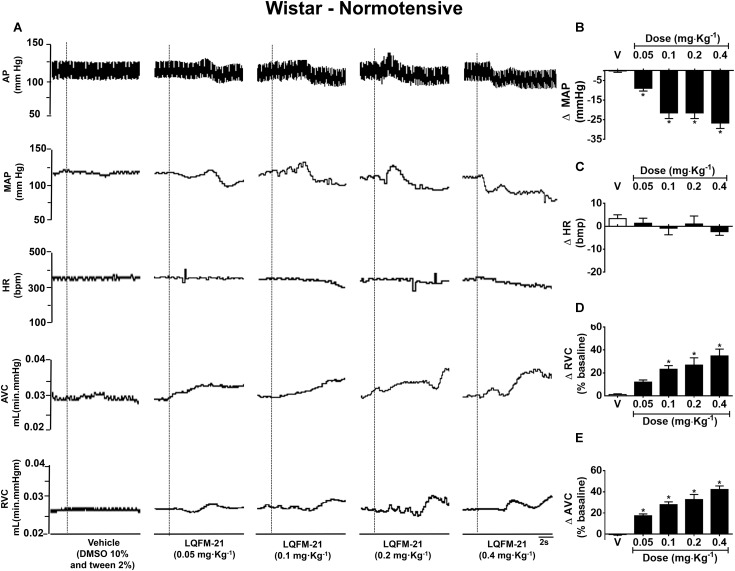
(A) Typical tracing of changes in cardiovascular parameters induced by intravenous injection of vehicle or LQFM-21 in anaesthetized NTR. Dashed line indicates the vehicle or LQFM-21 infusion. (B) Mean arterial pressure (MAP), (C) Heart rate (HR), (D) renal vascular conductance (RVC), (E) aortic vascular conductance (AVC) in anaesthetized NTR from the response to infusions of vehicle (∙) and LQFM-21 (∙) at doses 0.05, 0.1, 0.2, 0.4 mg⋅kg-1. Data are expressed as mean ± SEM, with their standard errors represented by vertical bars (n = 6). ∗Values significantly different from treated with vehicle, p < 0.05.